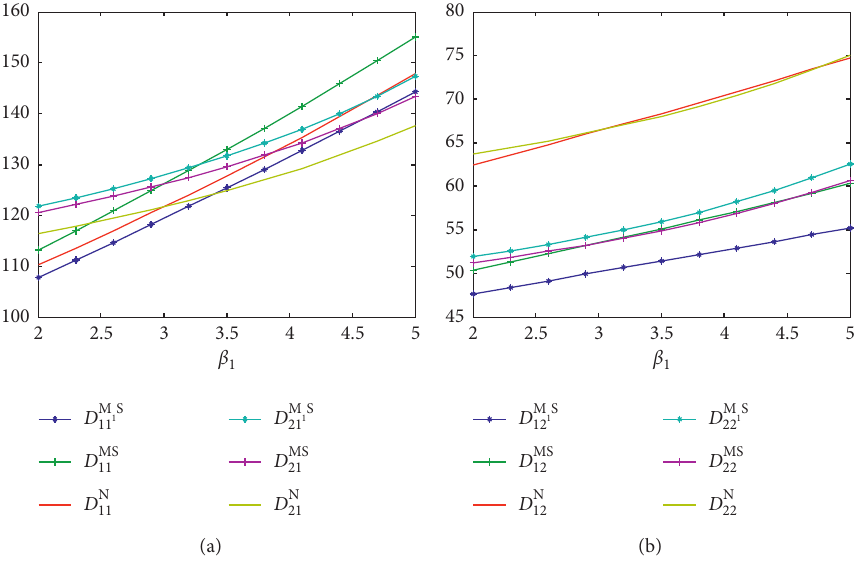
Figure 4: The effect of β on the optimal demands in the three models: (a) direct demand; (b) retail 1